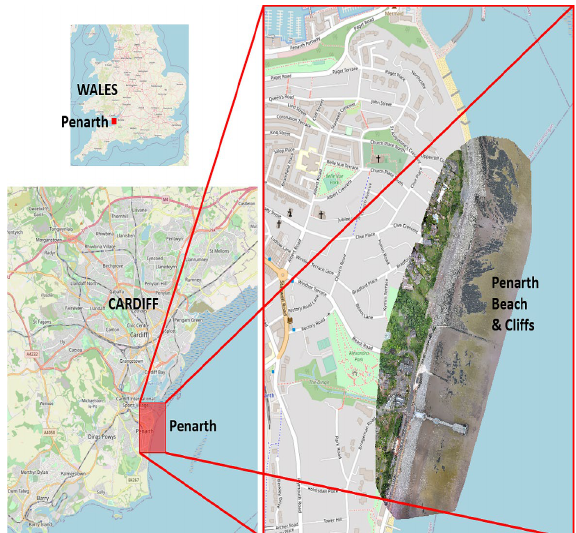
Figure 1 - Case Study Area of Penarth Beach in South Wales, UK.